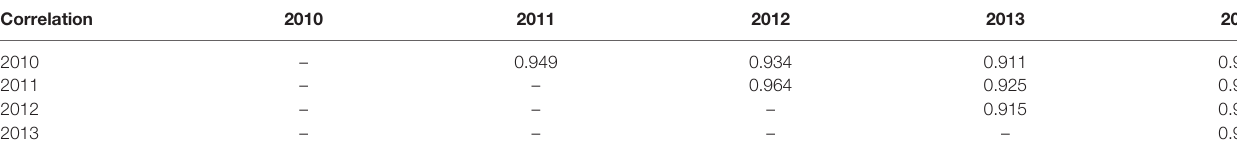
TABLE 3 | Correlation of T 0 min (mean “ minimum connectivity time ” ) between different